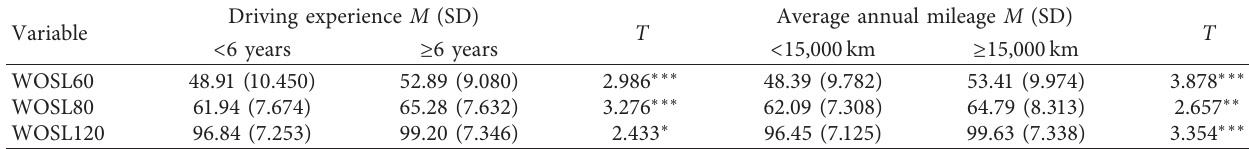
Table 4: Difference analysis of speed selection behaviour in low illumination.